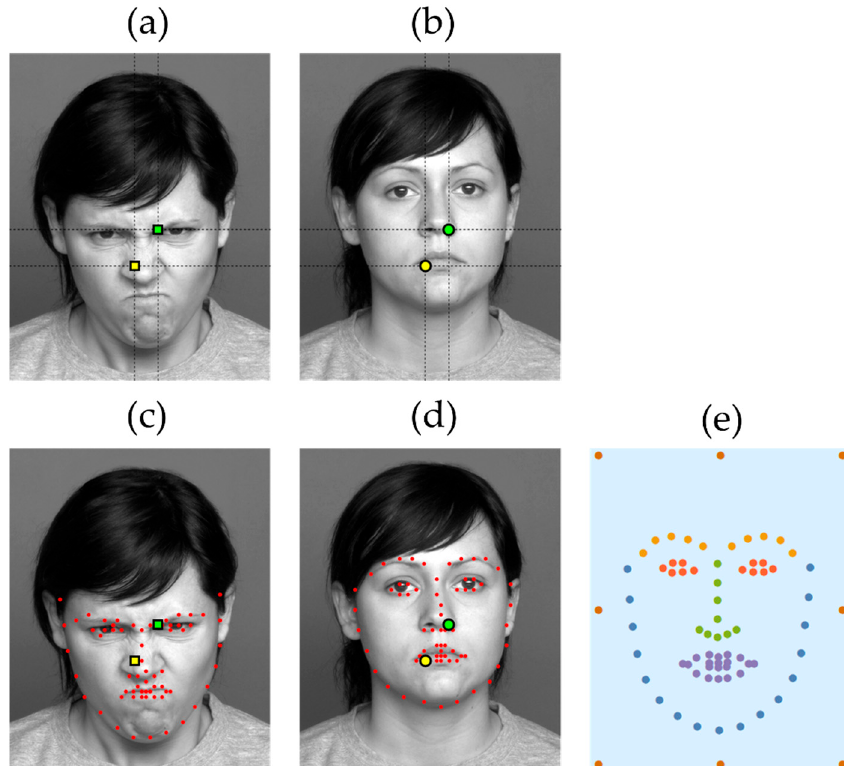
Figure 1. Despite having the same X-Y locations, the fixations indicated by yellow/green circles in the ( a ) image are aimed at different facial features than the corresponding yellow/green square-indicated fixations in the ( b ) image. To address this, we computed the locations of 68 key facial feature points (red dots in images c and d ) and assigned each fixation to its nearest feature point (AOI; area-of-interest). The average key point locations across all face images are shown in panel ( e ) which also illustrates how the points were grouped into the face outline (blue), mouth (violet), nose (green), eyes (red), eyebrows (orange), and exterior frame points (brown).